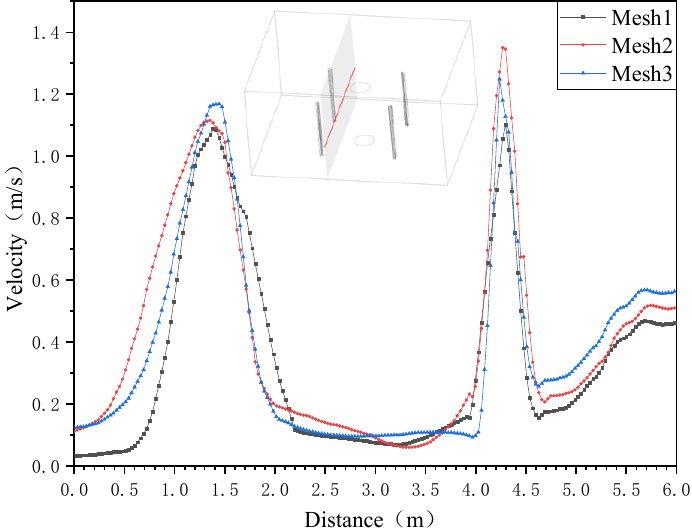
Figure 9. Comparison of horizontal velocities of different grids.